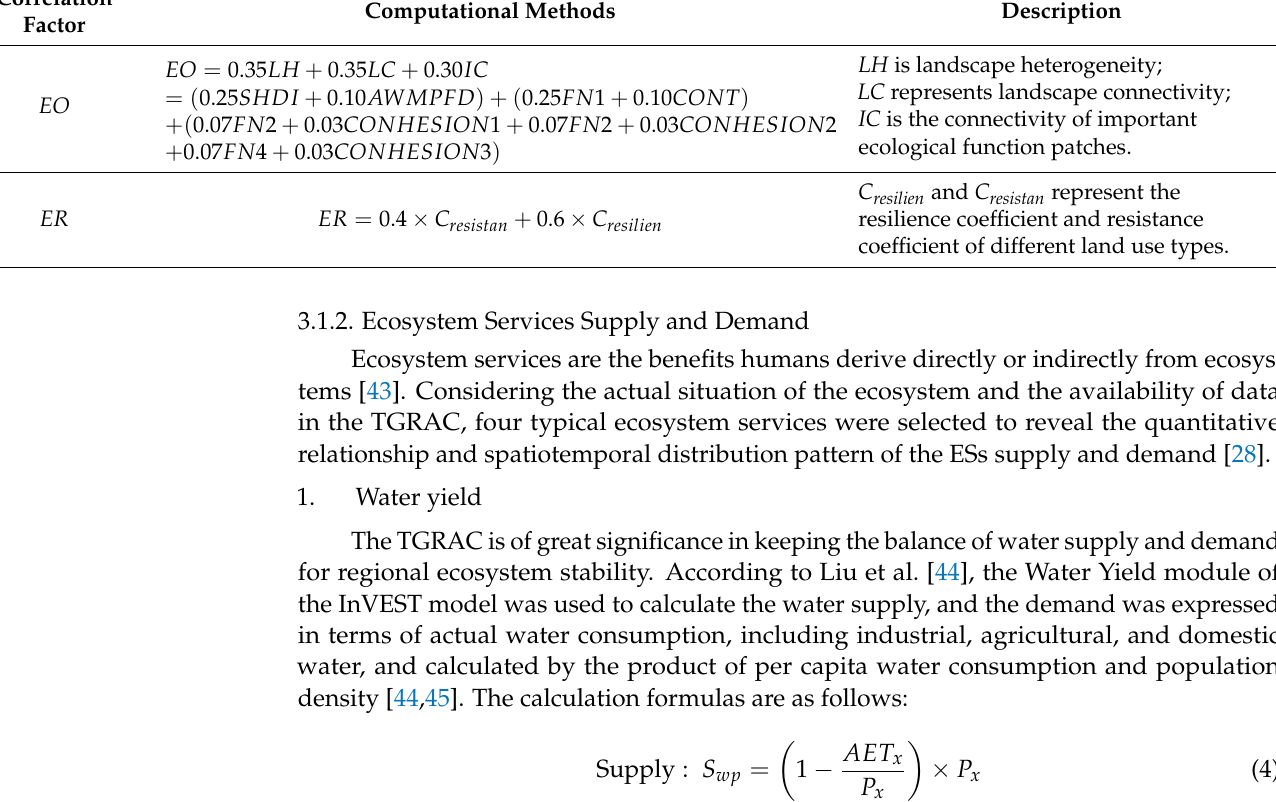
Table 1. Methods and processes of the ecosystem physical health assessment. Correlation Computational Methods Factor